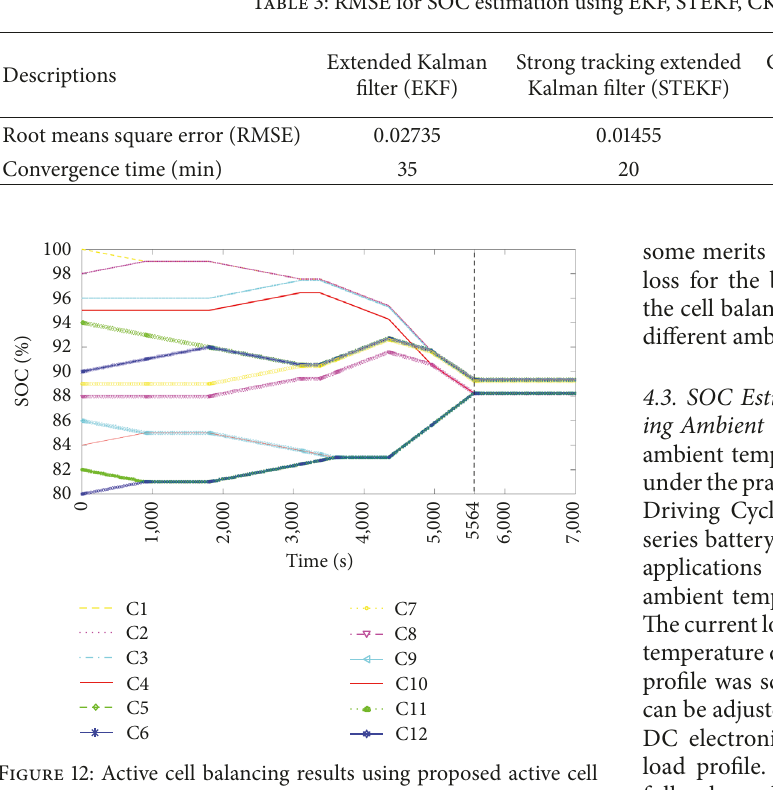
Table 3: RMSE for SOC estimation using EKF, STEKF, CKF, and STCEKF at 25 ∘ C.